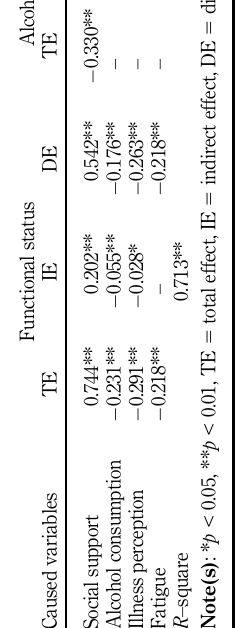
Table 4. The direct, indirect and total effects between variables of the study ( N 5